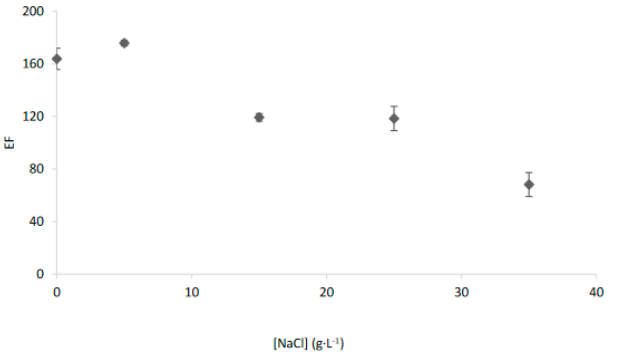
Figure 4. Salinity effect on the transport of Ag + with the EME system and Cyanex 471x in 1-octanol as organic phase.